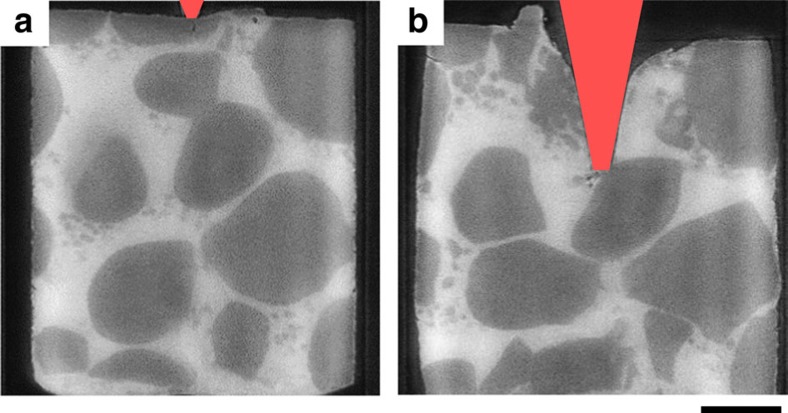
Influence of solid fraction.Longitudinal slices of semi-solid indentation of large globular Al–Cu grains at 570 °C: (62% solid volume fraction, average grain size: ∼450 μm): (a) before and (b) after 1-mm indentation at 0.5 μm s−1. No cracking was observed unlike with the 73% solid volume fraction sample. (Note: fine light grey patches are assumed to be newly nucleated grains due to thermal fluctuations; scale bar 400 μm).